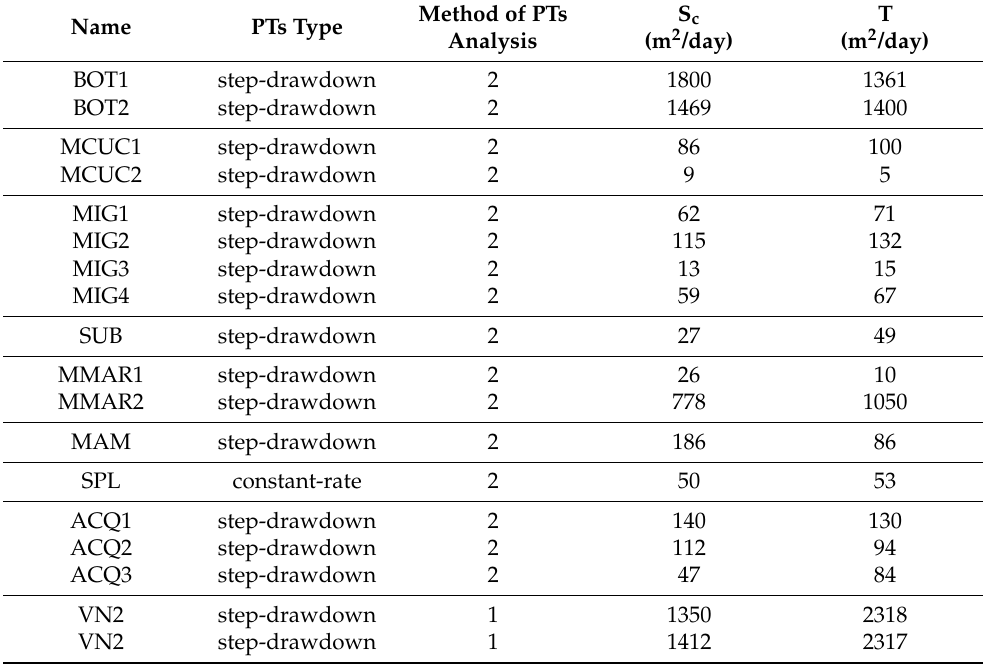
Table 3. Results of the pumping tests (PTs) with methods used for the interpretation. 1—Thiem– Dupuit method [34,35]; 2—Cooper and Jacob method [37]; 3—Warren and Root method [43];